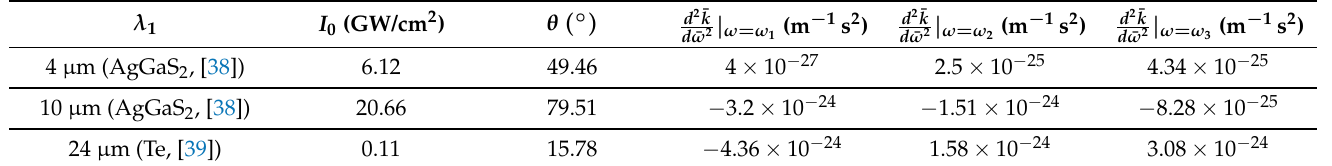
Table 1. Characteristics of nonlinear